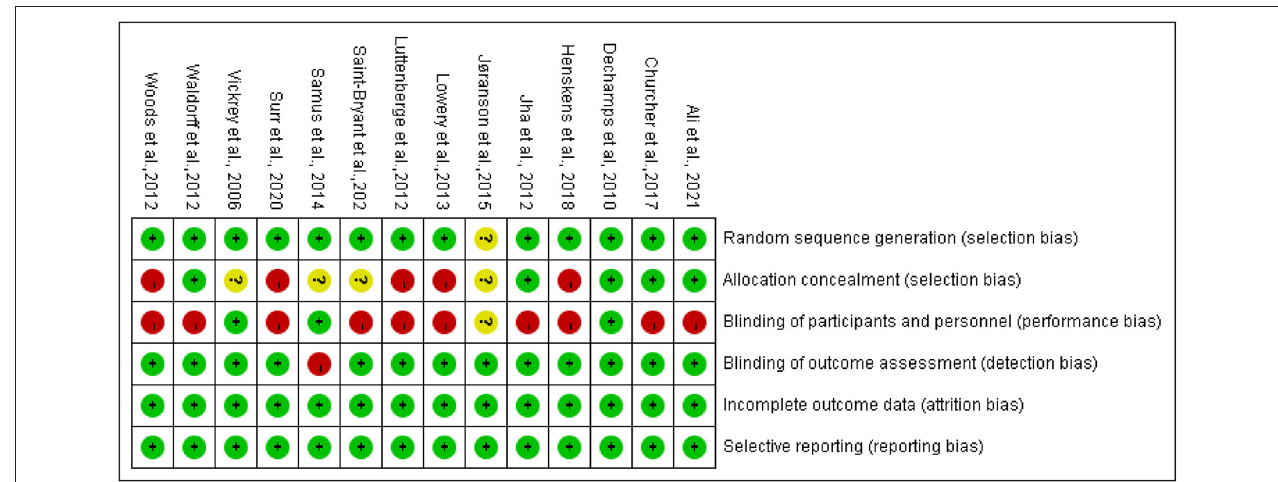
FIGURE 2 | Risk of bias